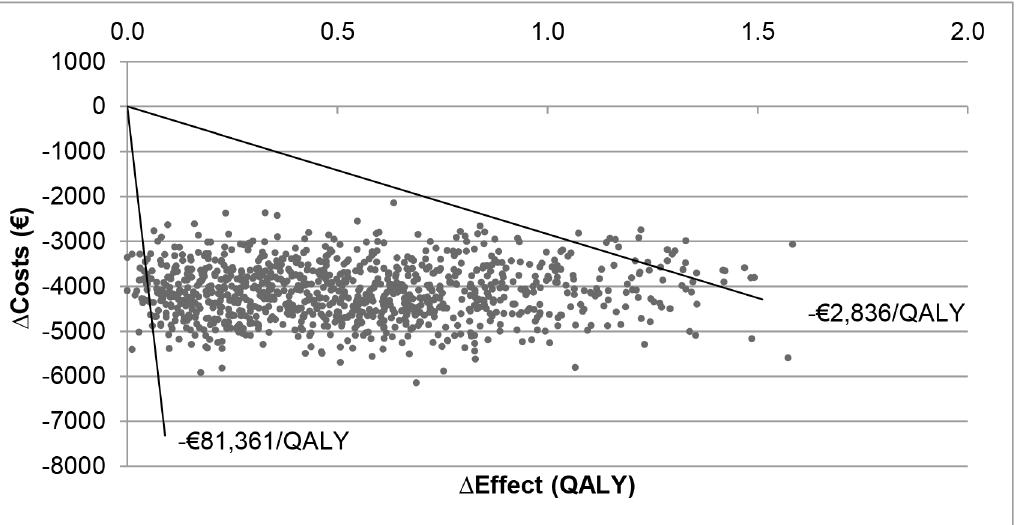
Fig 8. Cost and effect differences of probabilistic sensitivity analysis in cost-effectiveness plane and 95% confidence interval (Illustrative result for ER-MPH, example of MPH-OROS). QALY = Quality adjusted life years